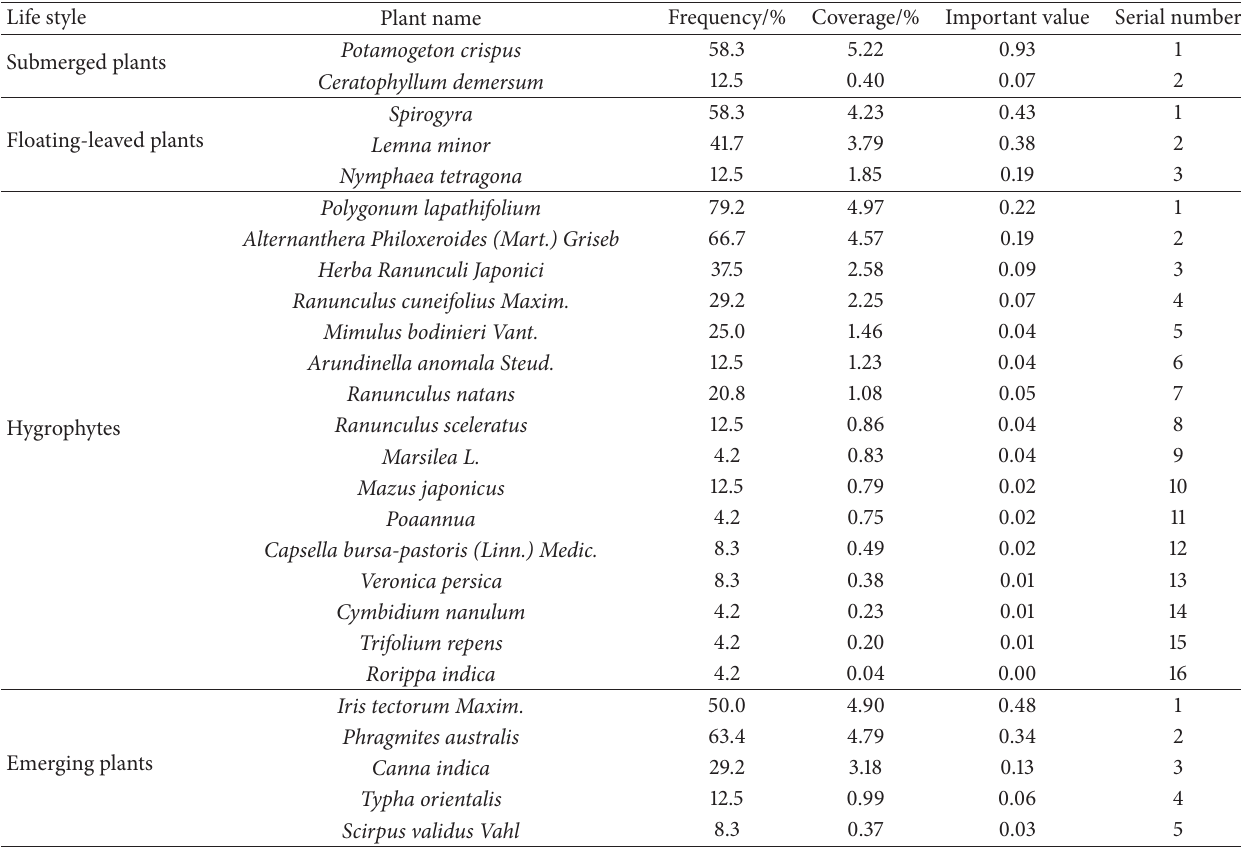
Table 3: Urban aquatic plants quantitative